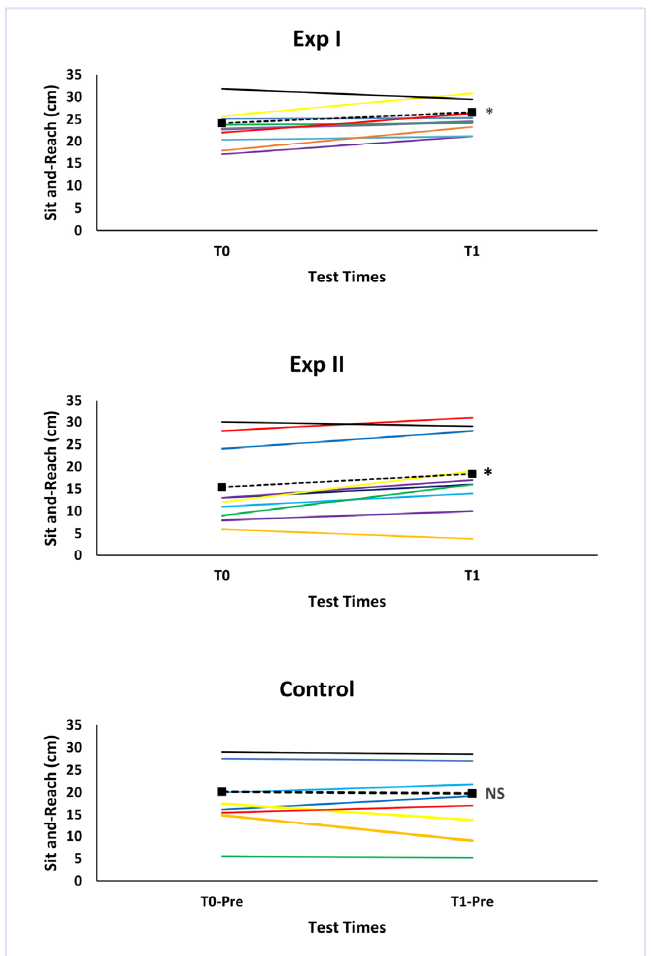
Figure 4. Chronic absolute changes over the 12 weeks (baseline—T0; T1—after the interventions) in the three groups. The solid lines of different color indicate individual changes, whereas the dashed lines indicate the mean value changes. * Significant changes ( p < 0.05).